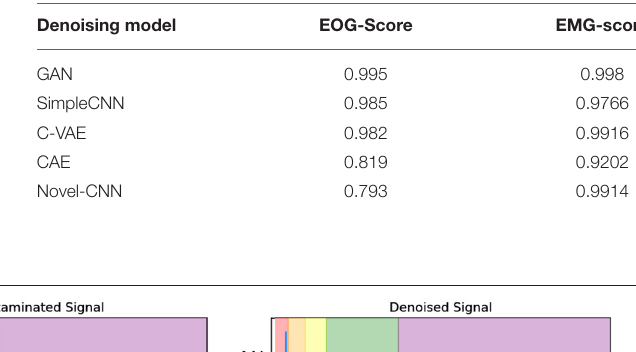
TABLE 3 | Co-sine similarity score of the different frequency bands after artifact removal (to ground truth).